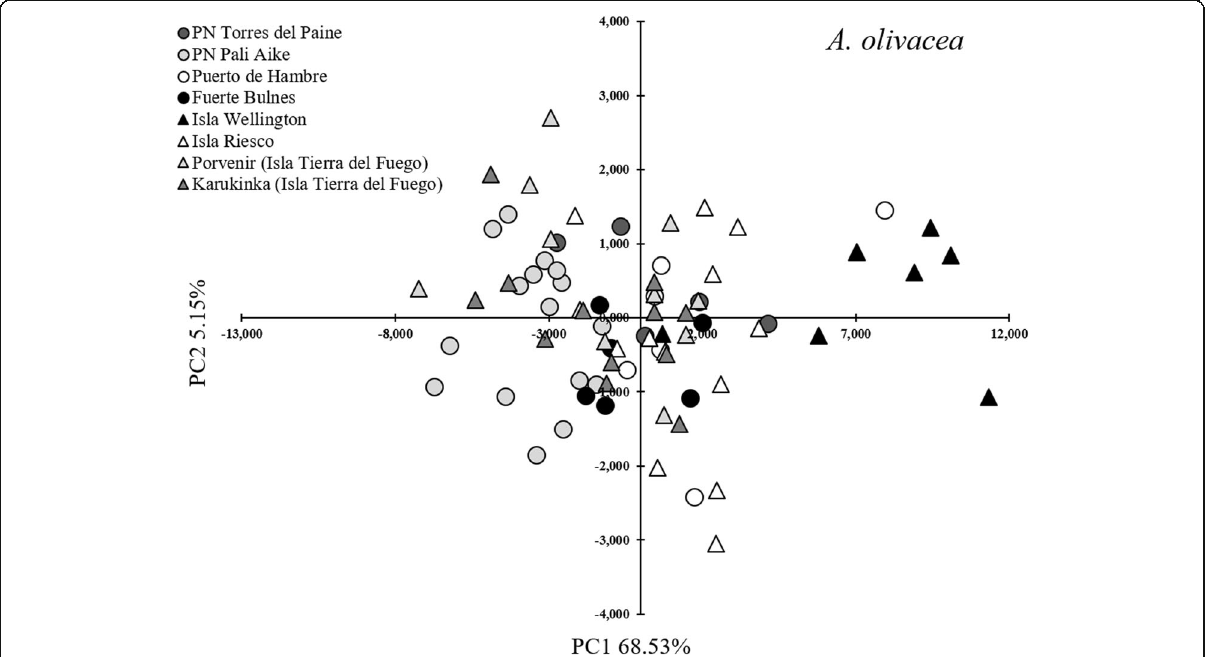
Fig. 3 Principal Component Analysis (PCA) of the linear morphometric approach for A. olivacea along Principal Component 1 and 2 (PC). PN = Parque Nacional, circles = mainland localities, triangles = insular